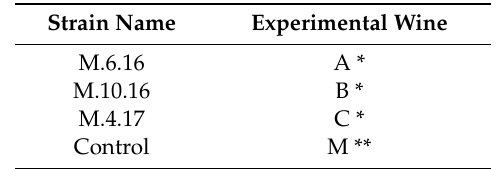
Table 1. Saccharomyces cerevisiae strains used to inoculate Merwah must of the 2019 season in pilot